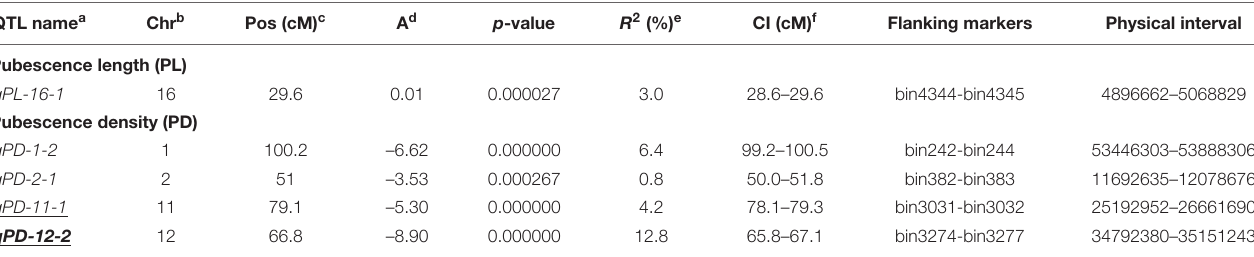
TABLE 3 | The additive QTLs identified for pubescence length and density in the inter-specific RIL population (NJRINP) with the mixed model-based composite interval mapping (MCIM) method.